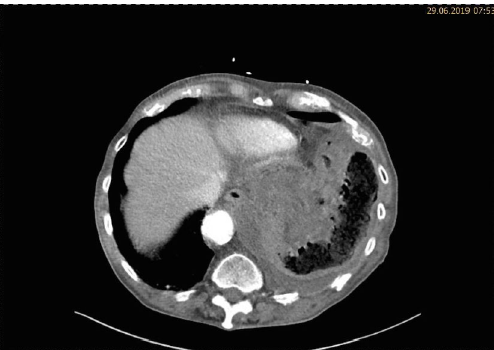
Figure 1: Coronary thoracoabdominal CT scan with left-sided seropneumothorax.